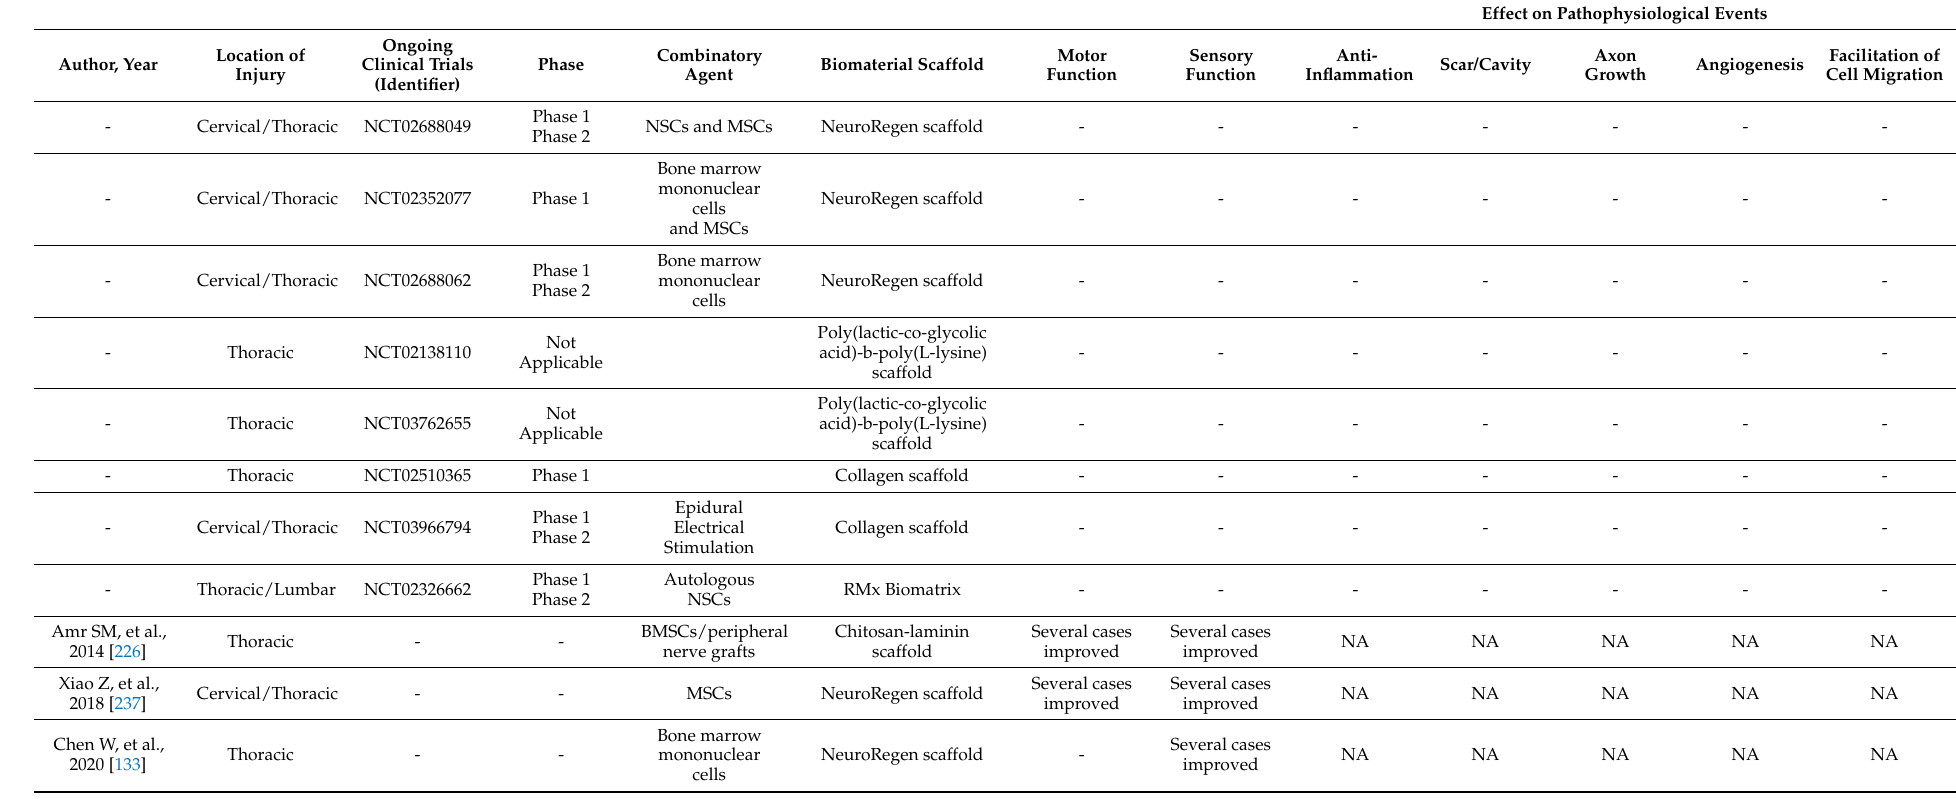
Table 6. Biomaterial scaffolds in clinical trials for SCI (https://www.clinicaltrials.gov/, accessed on 1 August